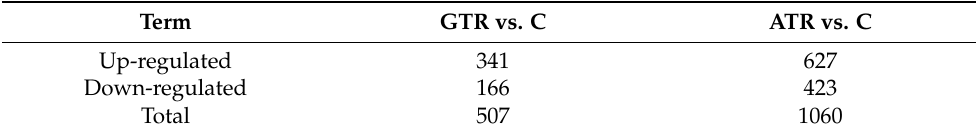
Table 1. The DEG (differentially expressed gene) numbers after two kinds of heat stress.